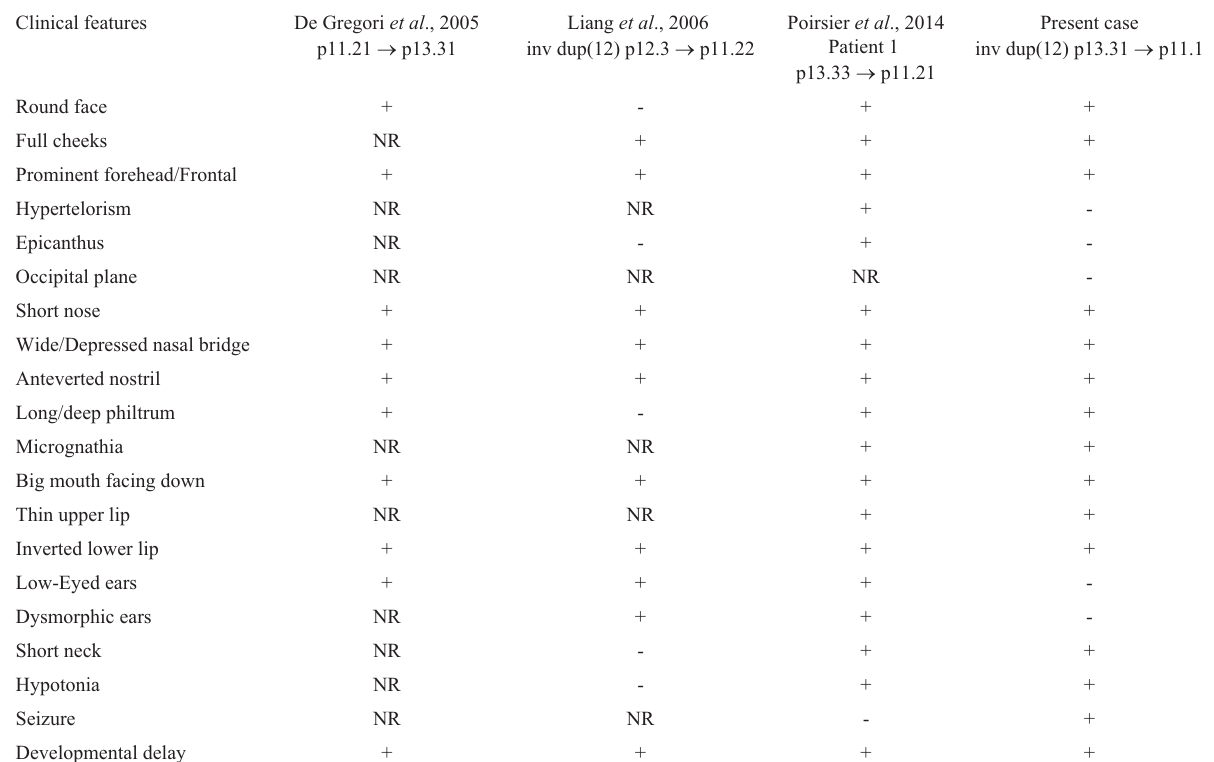
Table 1 - Comparison of the clinical features of patients with “pure” duplication 12p subgroup D. Clinical